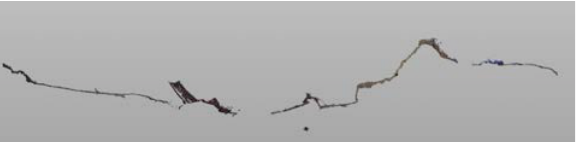
Figure 18. Generated cutting plan